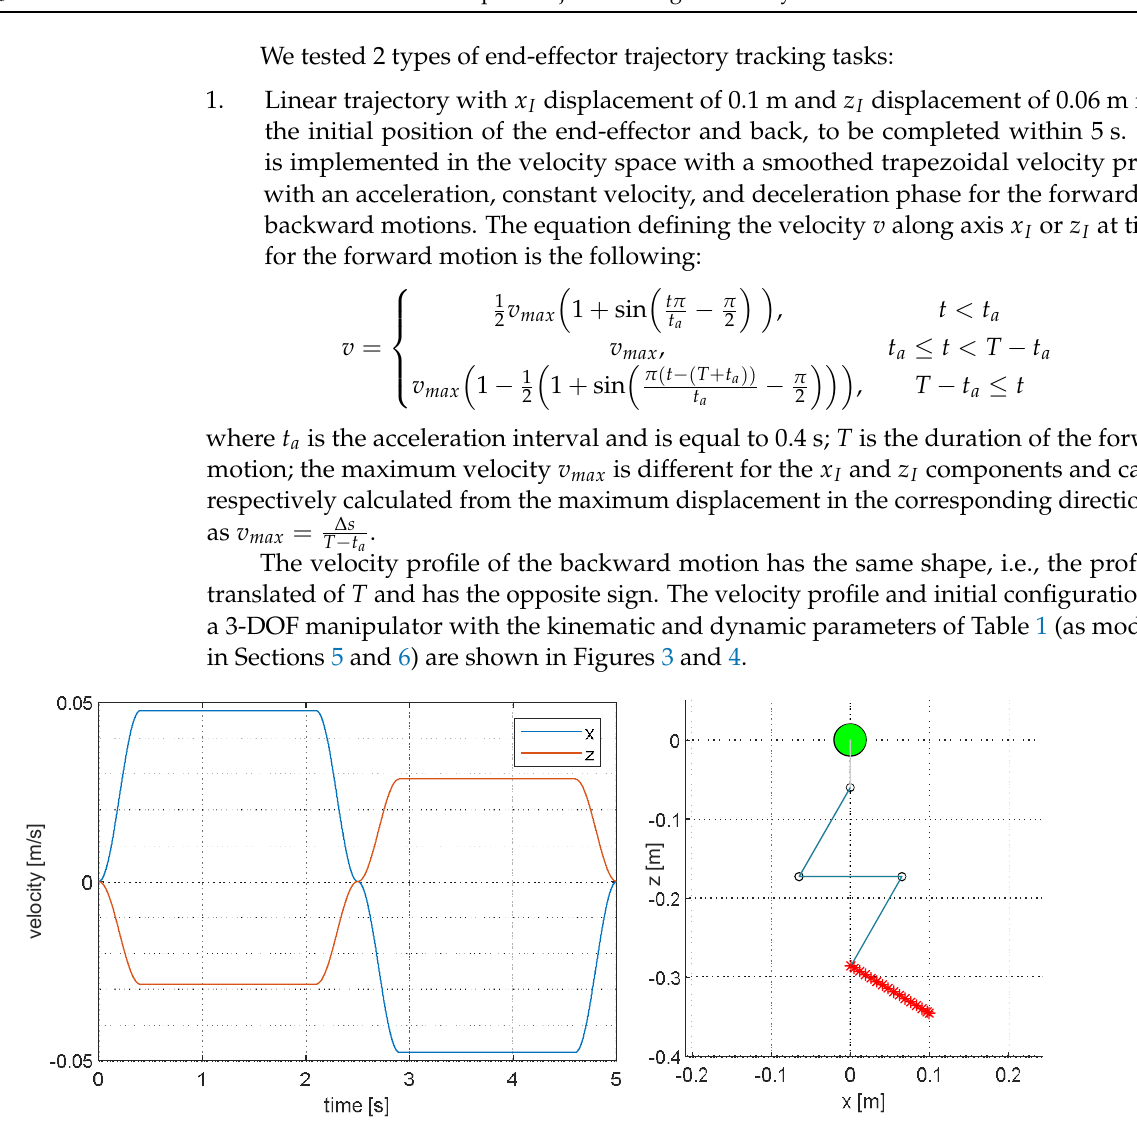
Figure 3. End-effector desired velocities for the line trajectory ( left ) and initial configuration for 3-DOF manipulator ( right ). The UAV base is the large green marker, joints are the black circles, links are the blue lines, and end-effector positions tracked are the red crosses.